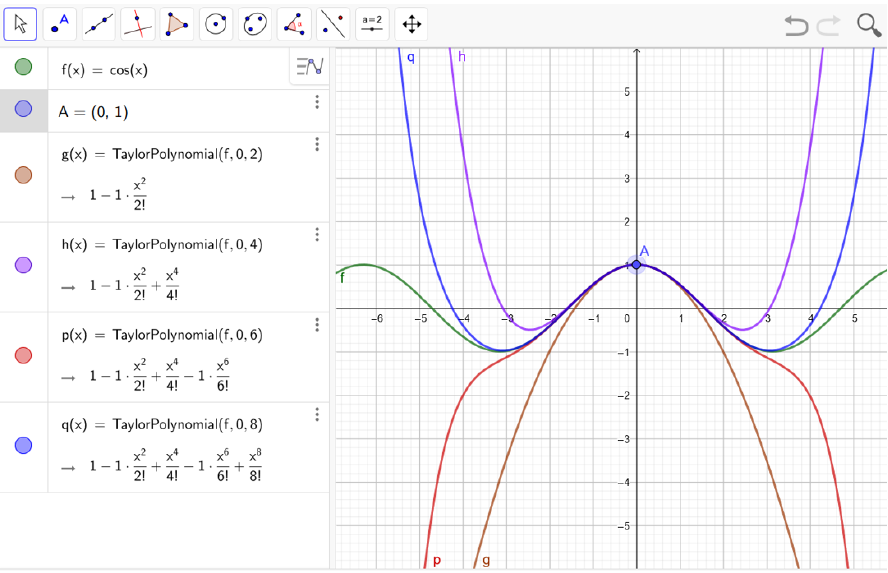
Figure 3. GeoGebra example about Taylor polynomials.